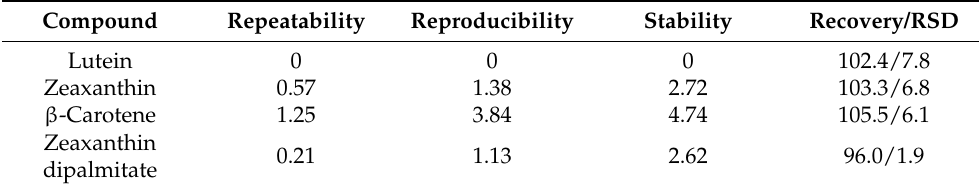
Table 4. The RSD of precision, repeatability, and accuracy of carotenoids in LB samples